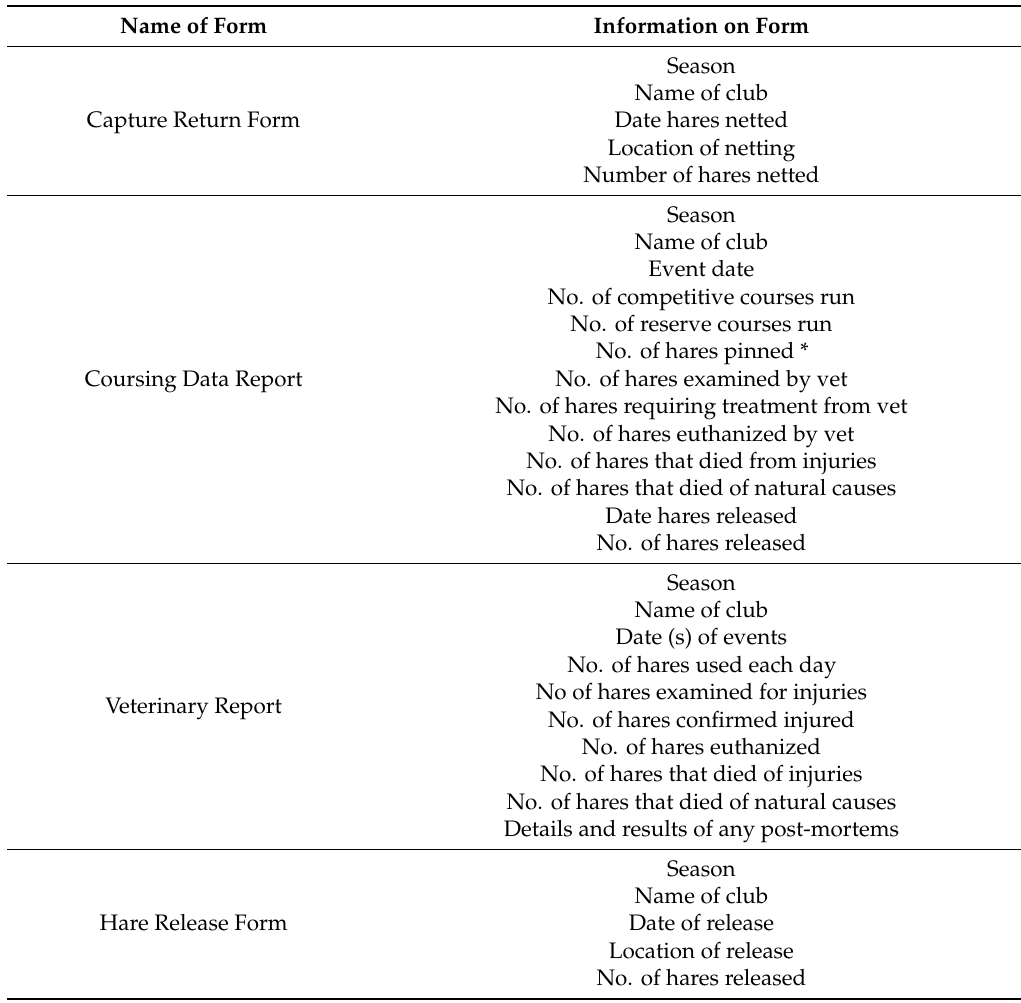
Table 1. Details of the forms available on the website of the National Parks and Wildlife Service. All of the information listed in the table was publicly available with the exception of the location of netting and release of hares which were redacted by National Parks and Wildlife Service (NPWS). Any information which identified individuals (e.g., name of veterinary practitioner) was also